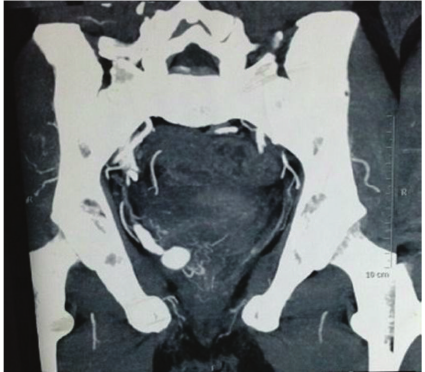
Figure 1: Pseudoaneurysm of branch of right internal iliac artery. Figure 2: Demonstrated terminal pseudoaneurysm protruding into bladder